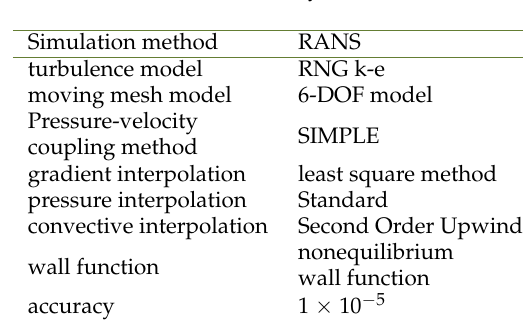
Fig. 6. Plunger with injection hole structure. Table 1. Mathematical model, discrete scheme and accuracy.